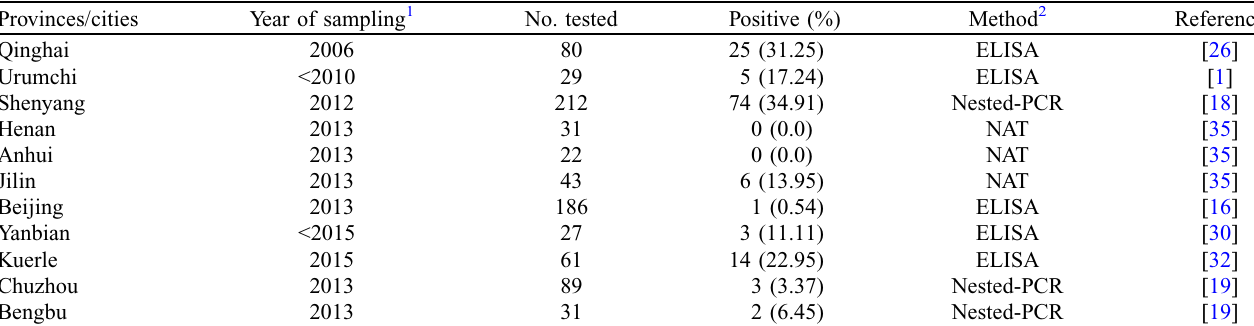
Table 1. The prevalence of Neospora caninum infection in dogs in the People’s Republic of China.